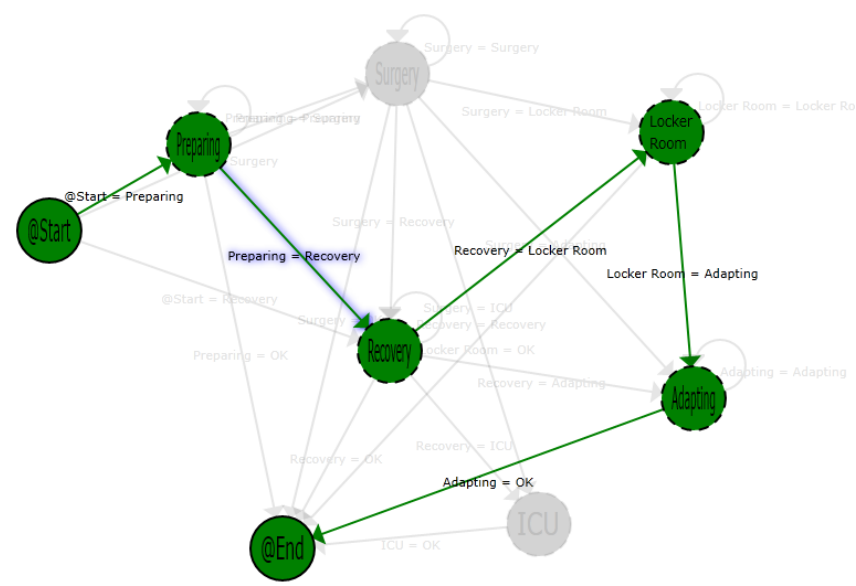
Figure 7. Path view of a single patient